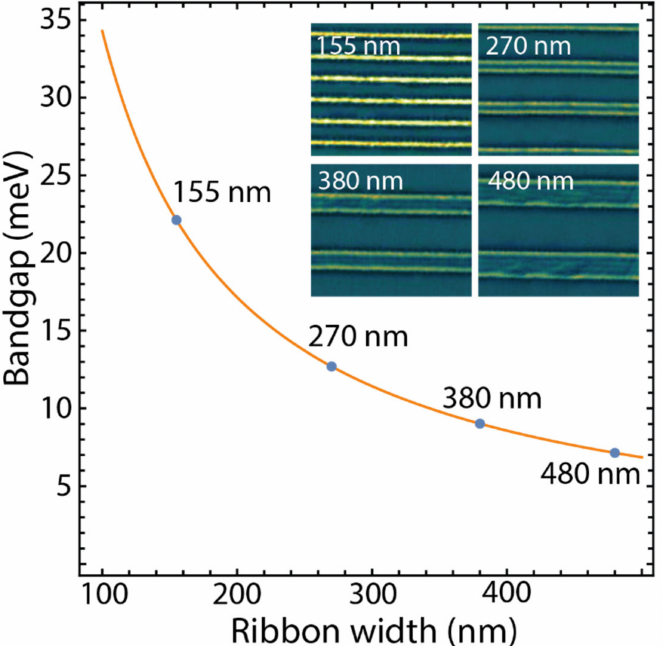
Figure 2. Bandgap ( ∆ ) as a function of the experimental ribbon widths (blue markers). The orange line is the fitting curve. Inset Figures show the experimentally realized 2D GNR arrays (reproduced with permission of Ref.